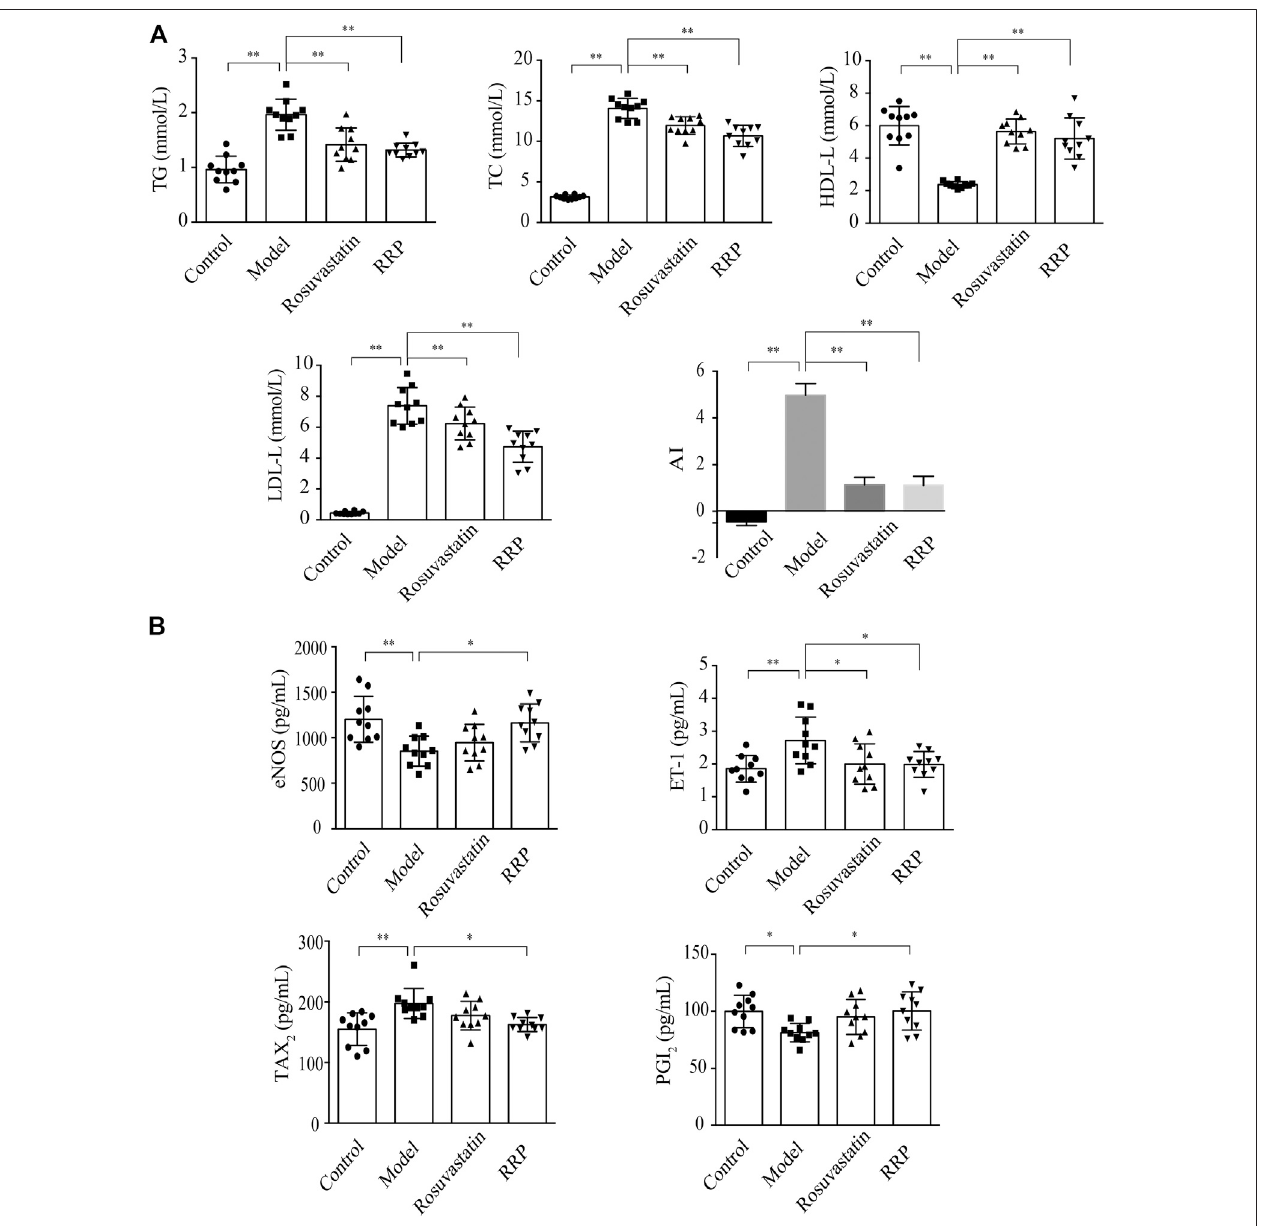
FIGURE 3 | RRP in fl uences lipids and secretion of vessel endothelial factors in serum. (A) Serum levels of lipids (TG, TC, LDL-C, and HDL-C) in mice. (B) Levels of eNOS, ET-1, PGI 2 , and TXA 2 in mice. The data are expressed as the mean ± SD, n (cid:2) 10 for each group. p p < 0.05, pp p < 0.001 vs. the model